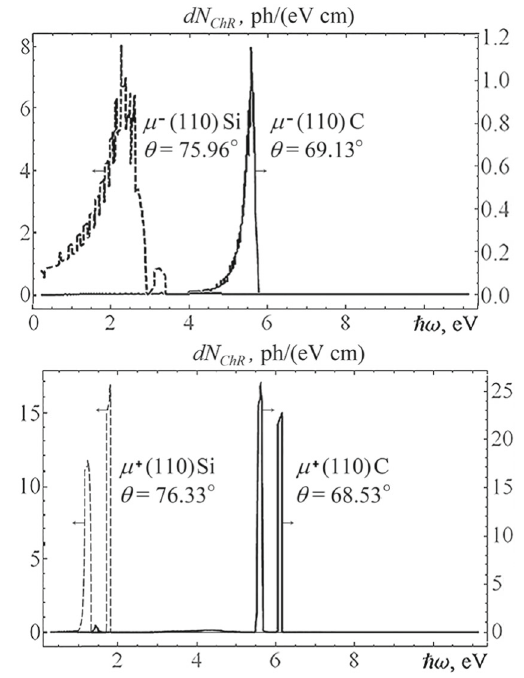
Fig. 8 Spectral distributions of ChCR photons emitted at polar angles θ corresponding to the threshold of crystals optical transparency